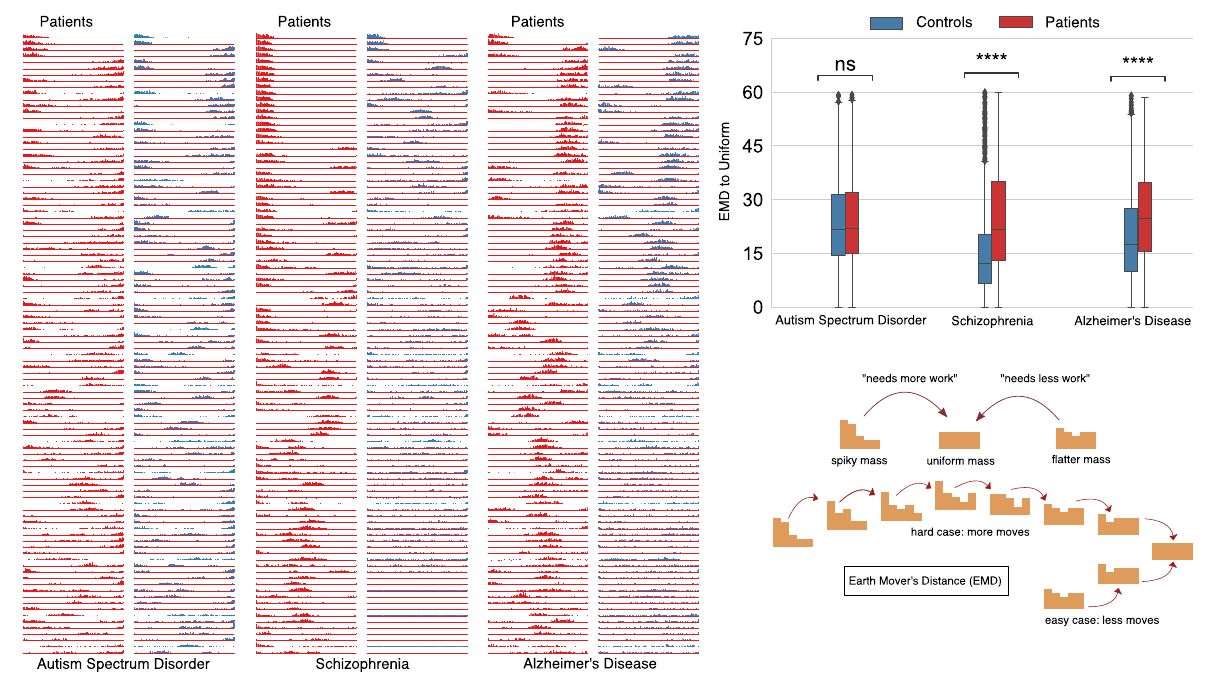
Figure 6. ( A ) Examples of the temporal density based on the top 5% values of the saliency maps from patients and controls for each disorder. It is noticeable that the temporal density for schizophrenia and Alzheimer’s patients is more focal in time as reflected in the spikiness, indicating that the discriminative activity for patients occurs predominantly in a shorter time interval. In contrast, for controls, model predictions do not relate to specific time intervals. For autism spectrum disorder, however, the whole MILC model did not capture any temporal adherence to the discriminative activity for patients. That is, the discriminatory events are not